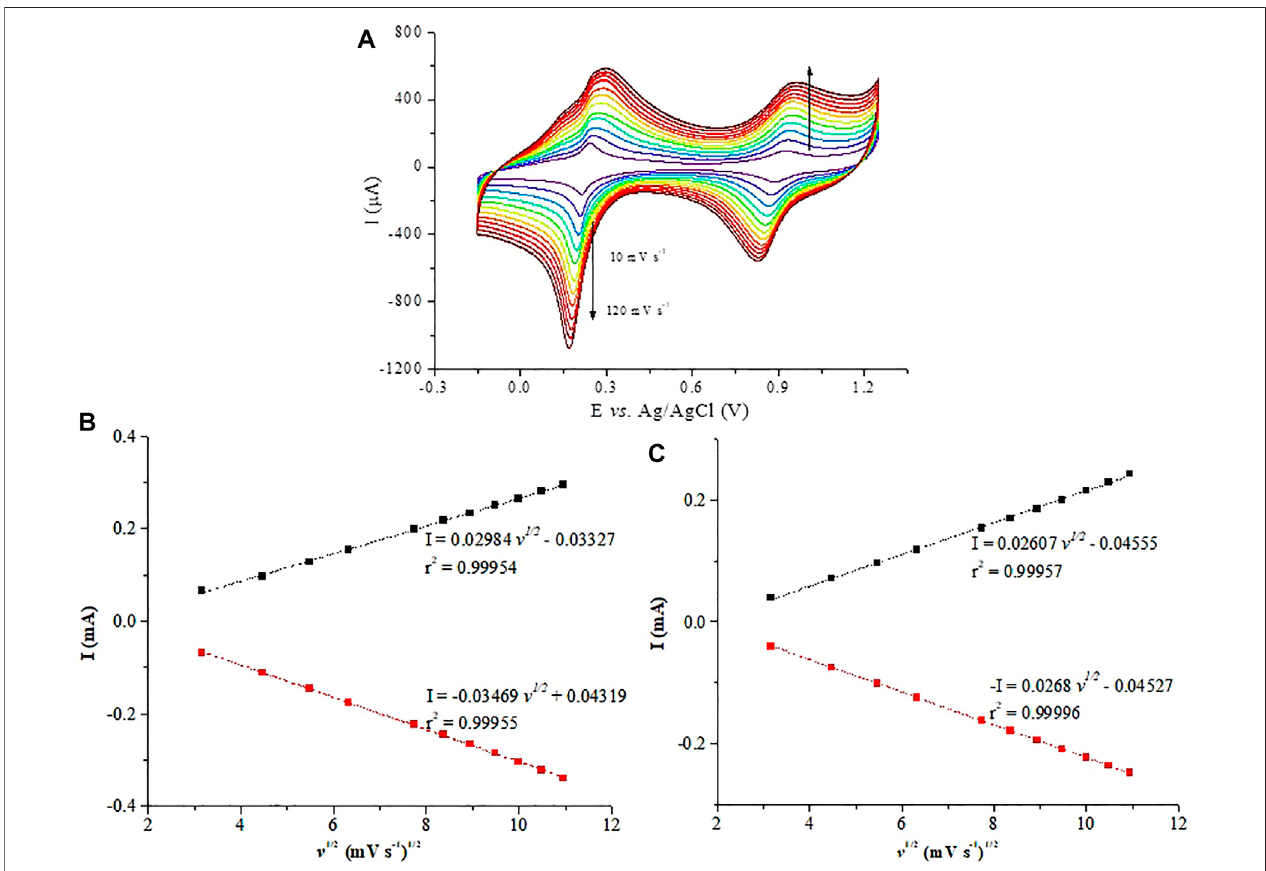
FIGURE 9 | (A) Cyclic voltammetry at PB-fCNT/TiO 2 .ZrO 2 (36)500 ° C.20/GC-modi fi ed electrode in PBS at pH 3.0 at different scan rates; (B) PB reduction; (C) PB oxidation peaks current vs. the square root of the scan rate, I vs. (v)1/2.